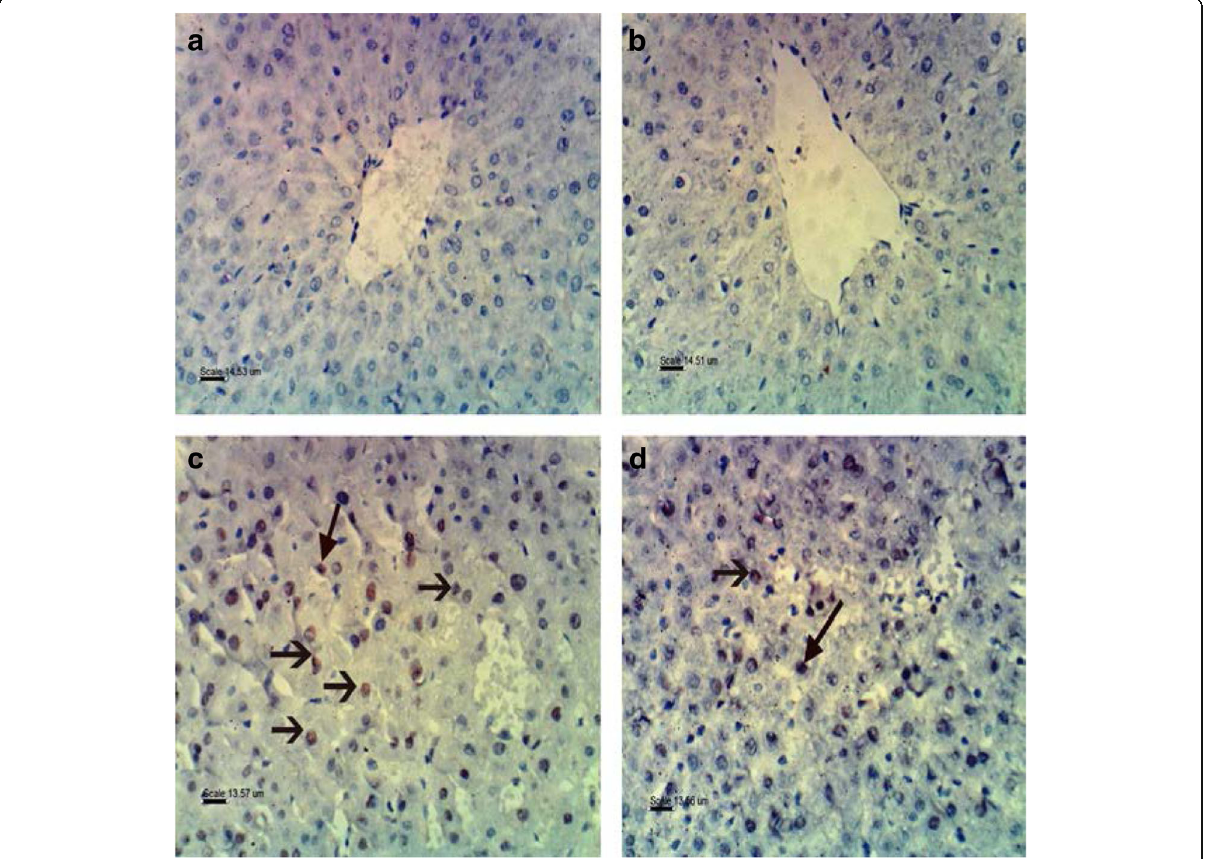
Fig. 2 Photomicrograph of immunohistochemical staining of Caspase 3 in liver of rat in examined groups: a Control group, showing negative immunohistochemical staining of caspase 3 immunoreactivity (bar, 14.53 μ m); b Karela administered rats, showing negative immunohistochemical staining of Caspase 3 (bar, 14.51 μ m); c Cholesterol administered group, showing strong immunohistochemical staining and immune reactivity of Caspase 3 (bar, 13.57 μ m); d Cholesterol and Karella treatment group, showing mild immunohistochemical staining of Caspase 3 (bar, 13.56 μ